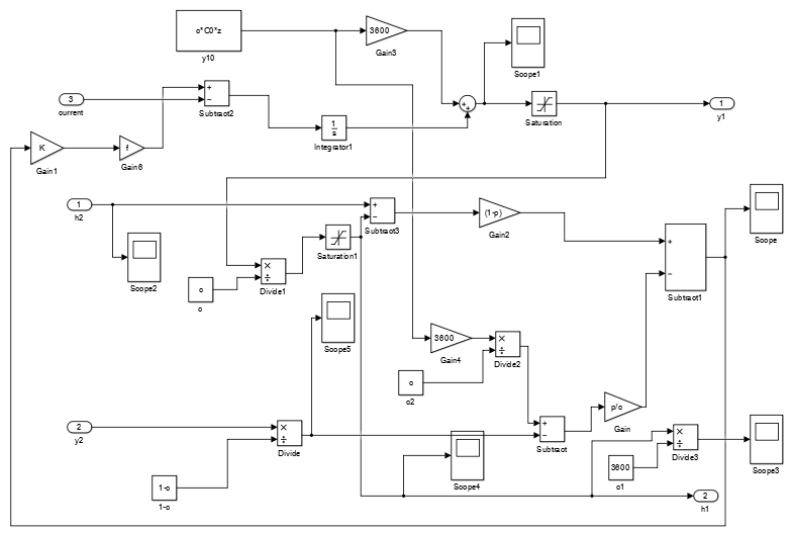
in the kinetic battery model (KiBaM) modeling. 1